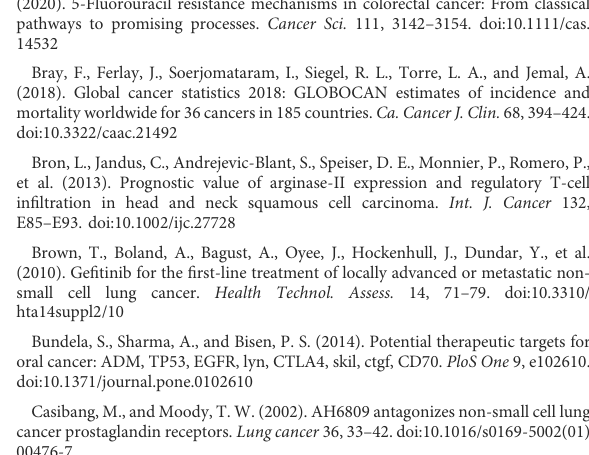
SUPPLEMENTARY FIGURE S2 Expression levels of model genes between low- and high-risk subgroups in TCGA (A) and GEO (B) cohorts. *** p < 0.001. GEO, The Gene Expression Omnibus, TCGA, The Cancer Genome Atlas. SUPPLEMENTARY FIGURE S3 Survival analyses of model genes in OSCC using Kaplan-Meier algorithm basedonTCGA (A-F) andGEO (G-L) cohorts.OSCC,Oralsquamouscell carcinoma, GEO, The Gene Expression Omnibus, TCGA, The Cancer Genome Atlas. SUPPLEMENTARY FIGURE S4 Survival analyses of clinical features in OSCC using Kaplan-Meier algorithm based on TCGA and GEO cohorts. TCGA cohort: (A) age, (B) gender, (C) grade, (D) clinical stage, (E) T stage and (F) N stage. GEO cohort: (G) age, (H) gender, and (I) clinical stage. OSCC, Oral squamous cellcarcinoma,GEO,TheGeneExpressionOmnibus,TCGA,TheCancer Genome Atlas. SUPPLEMENTARY FIGURE S5 Correlations between the risk score and the levels of immune score, stromal score and tumor purity according to TCGA (A-C) and GEO (D-E) cohorts. GEO, The Gene Expression Omnibus, TCGA, The Cancer Genome Atlas. SUPPLEMENTARY FIGURE S6 Immune cells and immune-related functions with prognostic values in OSCC on basis of TCGA and GEO cohorts. OSCC, Oral squamous cell carcinoma, GEO, The Gene Expression Omnibus, TCGA, The Cancer Genome Atlas. SUPPLEMENTARY FIGURE S7 The IC50 of selected chemotherapeutic agents between different risk subgroups of OSCC and correlations between the risk score and the IC50 of selected chemotherapeutic agents in TCGA cohort based on CGP, GDSC2 and CTRP databases. OSCC, Oral squamous cell carcinoma, IC50, Half-maximal inhibitory concentration, TCGA, The Cancer Genome Atlas, CGP, the Cancer Genome Project, GDSC, Genomics of Drug Sensitivity in Cancer, CTRP, Cancer Therapeutics Response Portal. SUPPLEMENTARY FIGURE S8